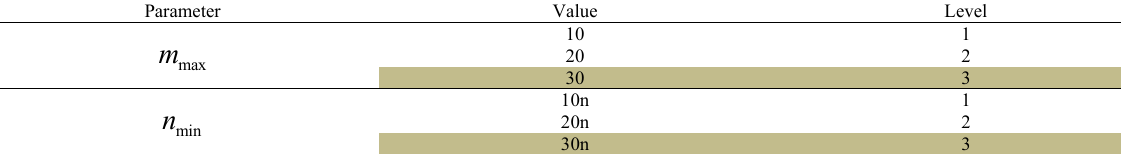
Parameters of the proposed VNS algorithm and their levels